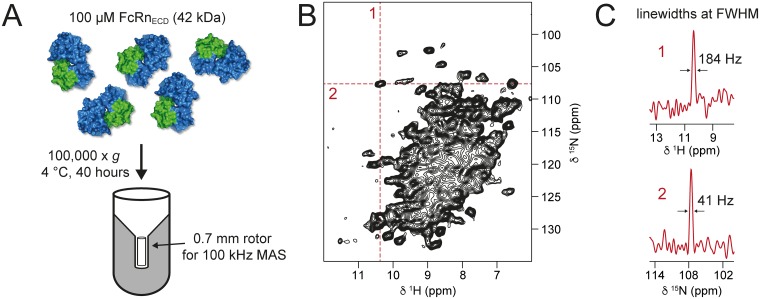
Proton-detected MAS NMR on fully protonated FcRnECD.(A) The soluble FcRnECD (42 kDa) was sedimented by ultracentrifugation at 100,000 x g directly into a 0.7 mm MAS NMR rotor using a home-made filling tool. (B) 2D 15N-1H correlation spectrum recorded at 100 kHz MAS of fully protonated [13C,15N]-labeled FcRnECD. (C) Typical linewidths of 1H (1) and 15N (2) at full-width-half-maximum (FWHM) of a selected cross peak from the 15N-1H spectrum. β2m, β2-microglobulin; FcRn, neonatal Fc receptor; FcRnECD, extracellular domain of the neonatal Fc receptor.